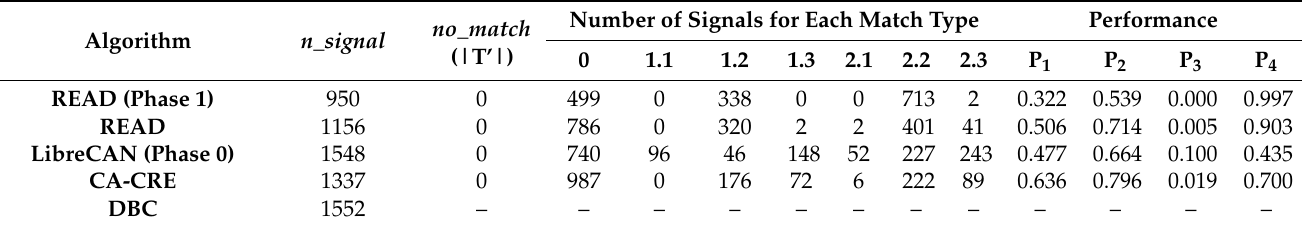
Table 10. Comparison of the four algorithms on the simulated CAN